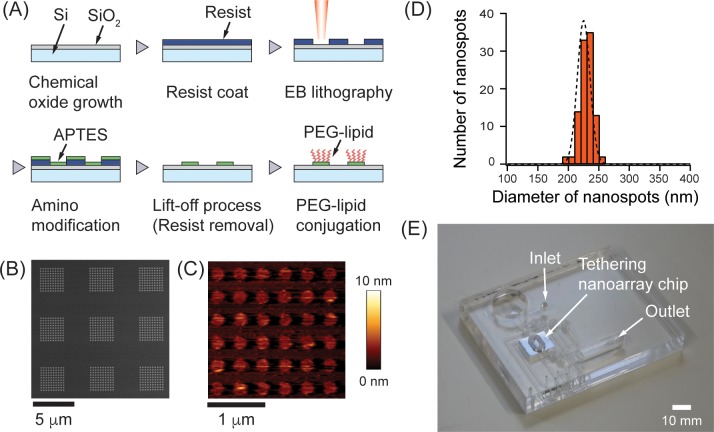
Hybrid nanofabrication process for forming an array of nanospots.(A) Schematic that depicts steps for fabricating PEG-lipid modified nanoarrays such as EB lithography, lift-off process, and selective chemical modification. (B) SEM image of EB resists film perforated with the 200-nm diameter nanoholes array. Bright spots correspond to delineated nanoholes, whereas dark regions correspond to the resist film. (C) Typical AFM image of the nanospots after the modification of both PEG-lipids and methoxy PEGs on amino modified spots. (D) Distribution of the nanospot diameters (n = 100). (E) Image of tethering nanoarray chip embedded in the microfluidic device.